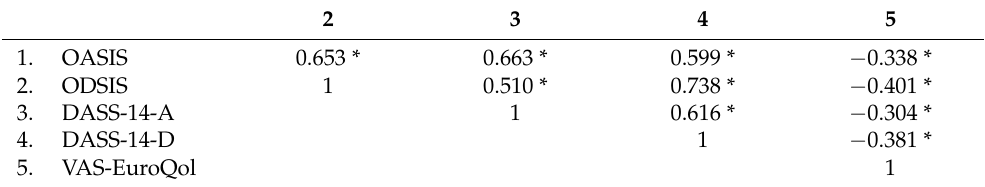
Table 4. Correlations between OASIS, ODSIS, DASS-14-A, DASS-14-D and VAS-EuroQol.